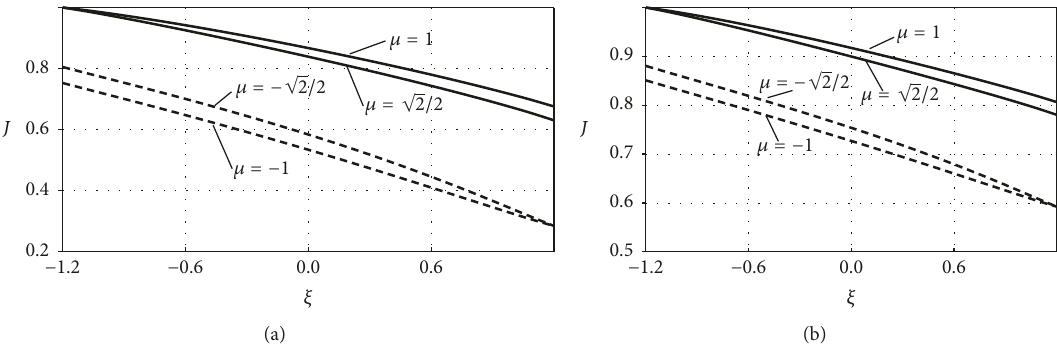
Figure 1: Dependencies of dimensionless intensity of radiation on spatial coordinate 𝜉 for different direction of its incidence at two values of hemispherical emissivity 𝜀 1 : ( 1 ) – 𝜀 = 0.2 ; (b) 𝜀 = 0.5 .